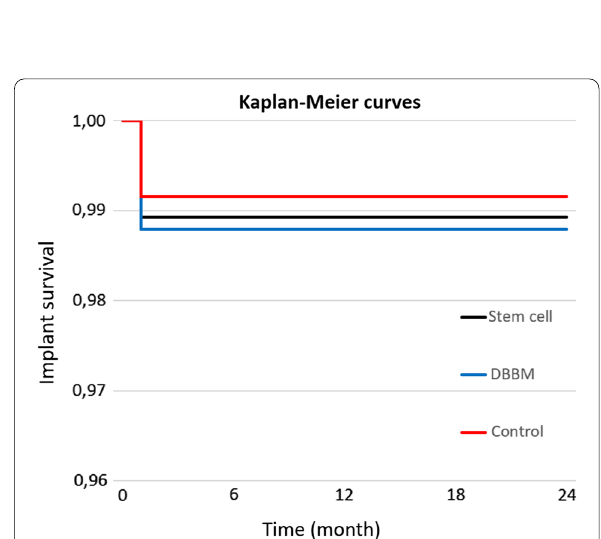
Fig. 5 Kaplan–Meier curve for the implant survival of the three groups: seven of the 673 implants had to be removed due to failed osseointegration: two of 188 implants in the stem cell group, three of 248 implants in the DBBM group and two of 237 implants in the Control